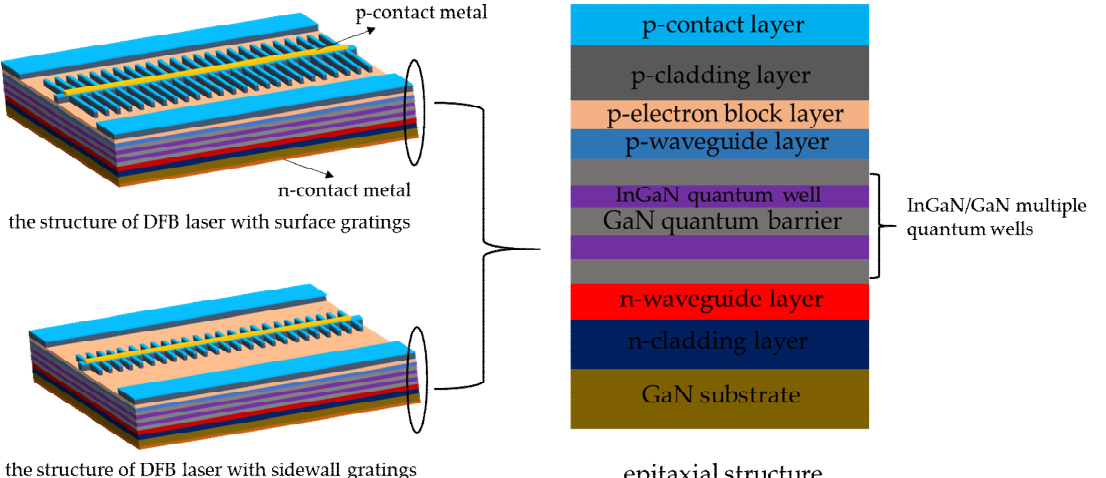
Figure 3. The structures of processed distributed feedback laser diodes (DFB-LDs) with surface gratings and sidewall gratings, as well as the diagrammatic drawing of the cross profile of the gallium nitride (GaN)-based epitaxial wafer.